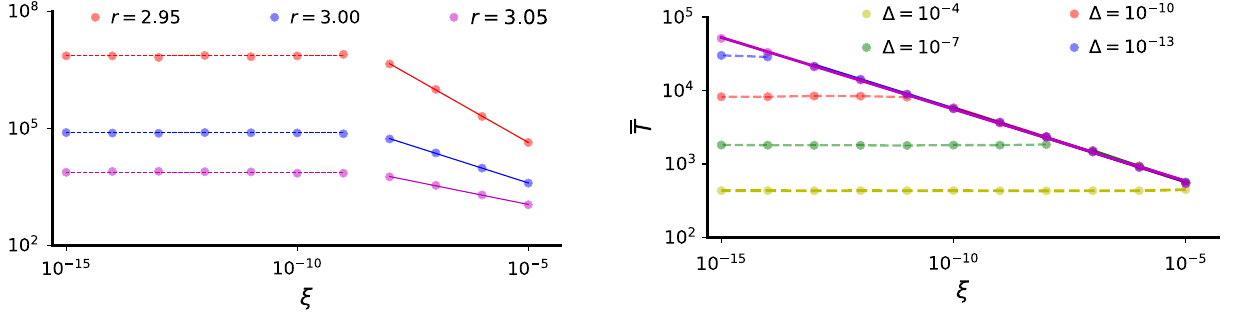
¯ T 10. Average switching period as a function of noise intensity ξ for various r . The system is the network of logistic maps in Fig. 1(a) for σ ¼ 1 . 7 , and the noise is Gaussian (but with the short-wavelength component filtered out). The flatness of the fitting lines below ξ ¼ 10 − 9 confirms that short-wavelength bifurcation is the dominant route for chimera switching. ¯ T average switching period becomes independent of ξ